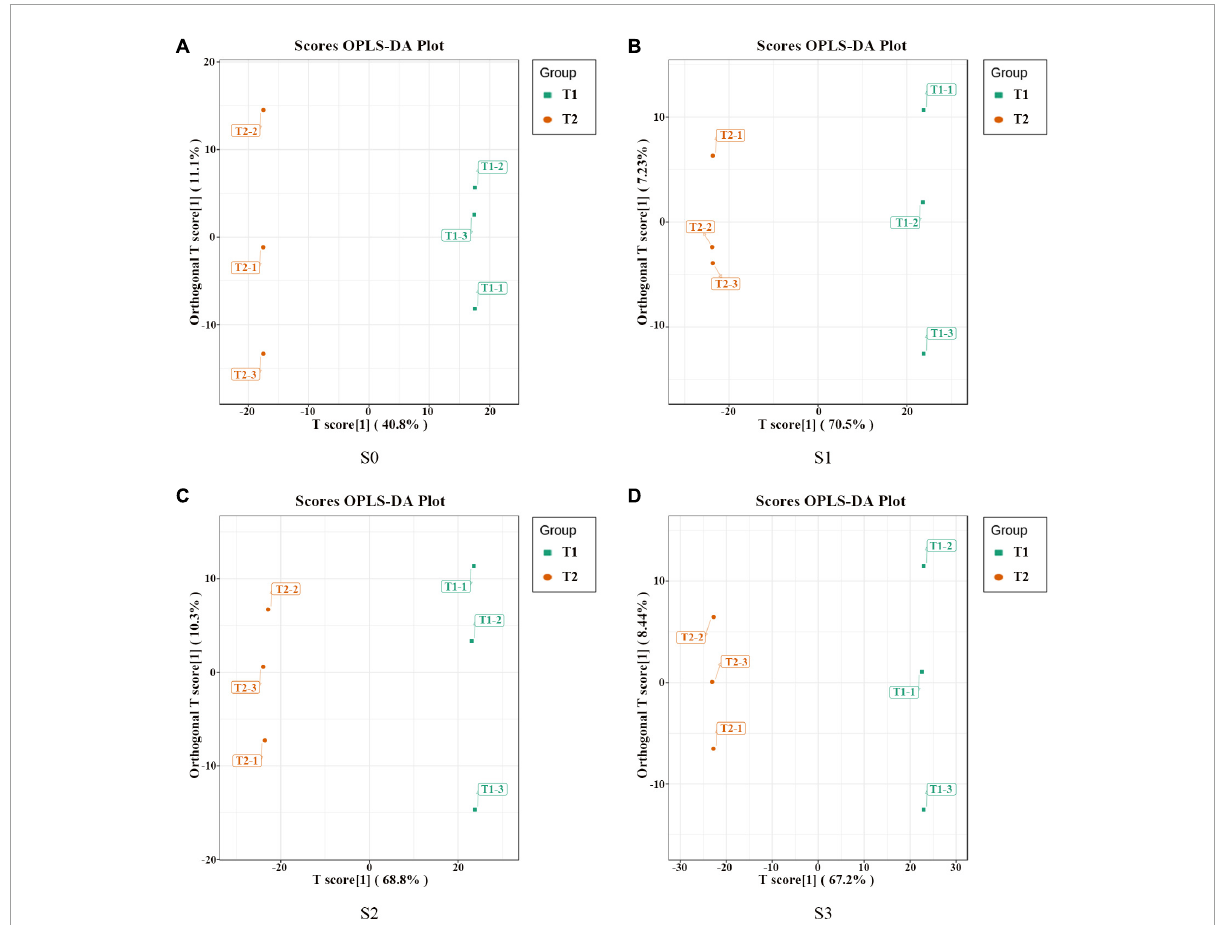
FIGURE4 OPLS-DA analysis of metabolites in fermented rapeseed cake. (A) OPLS-DA analysis of metabolites in fermented rapeseed cake in S0. (B) OPLS-DA analysis of metabolites in fermented rapeseed cake in S1. (C) OPLS-DA analysis of metabolites in fermented rapeseed cake in S2. (D) OPLS-DA analysis of metabolites in fermented rapeseed cake in S3.